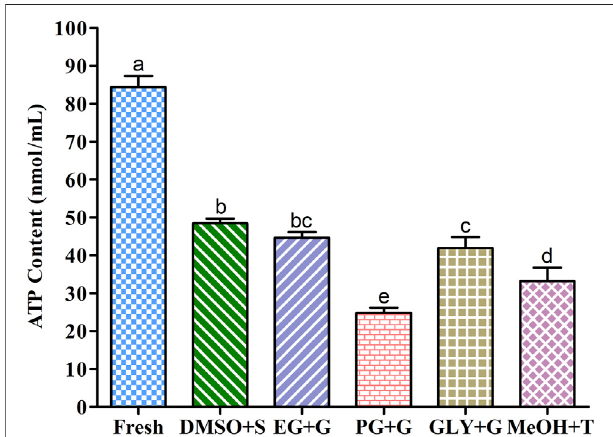
FIGURE 6 | Adenosine triphosphate (ATP) contents in different types of post-thaw sperm cryopreserved using saccharides. DMSO + S: 8% dimethyl sulfoxide (DMSO) combined with 3% sucrose (S), EG + G: 8% ethylene glycol (EG) combined with 1% glucose (G), PG + G: 6% propylene glycol (PG) combined with 2% glucose (G), GLY + G; 2% glycerol combined with 3% glucose (G), and MeOH + T: 2% methanol (MeOH) combined with 4% trehalose (T). Results are presented as mean values ±standard deviation ( n = 10). Signi fi cantly different levels ( p < 0.05) are denoted by different